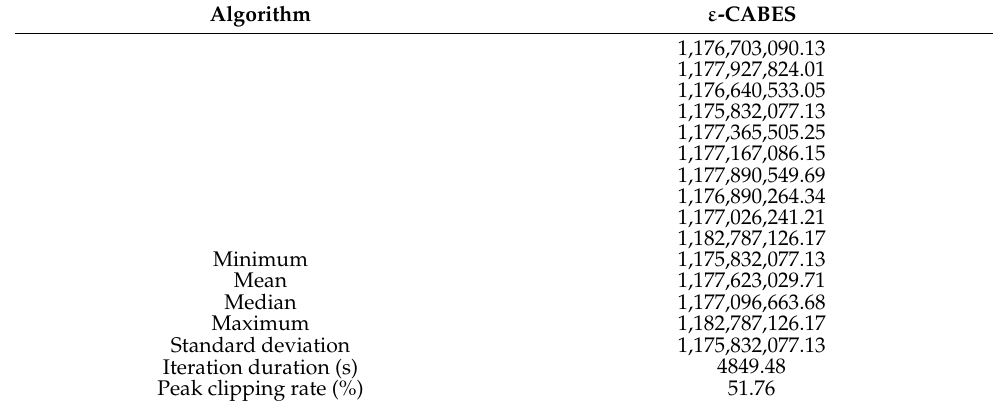
Table 8. Operation results of reservoirs in Luanhe River Basin using different